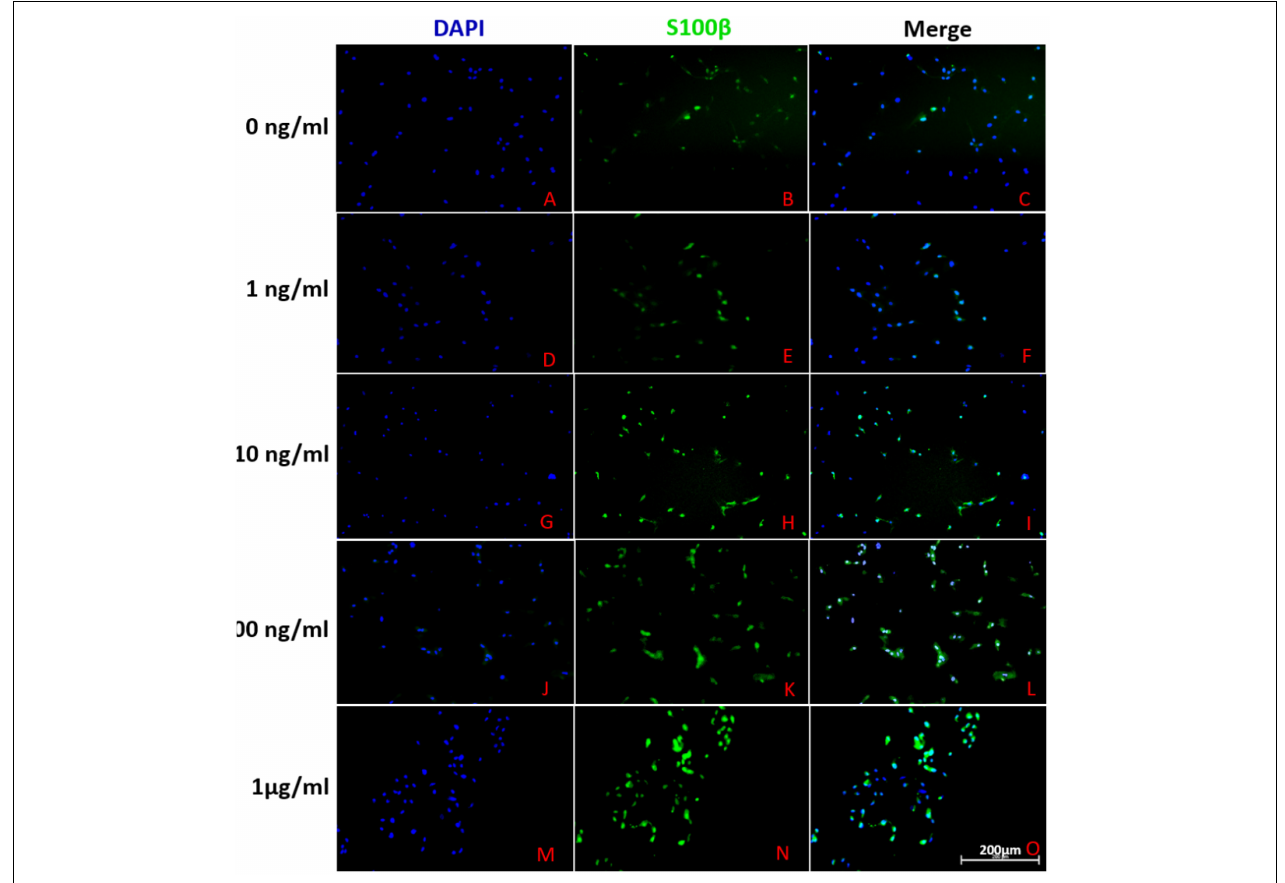
FIGURE 2 | Representative immunofluorescence photographs of differentiated ADSCs derived from different groups. (A–C) , (D–F) , (G–I) , (J–L) and (M–O) described the S100 expression in ADSCs treated with 0, 1, 10, 100 and 1000 ng/ml FK506 respectively. The leftmost column of figures represented cell nuclei stained with blue fluorescence of DAPI. In the second column, the green fluorescence corresponded to S100-positive cells. The rightmost column of figures represented the merge of the two fluorescence from same area. Scale bar = 200 µ